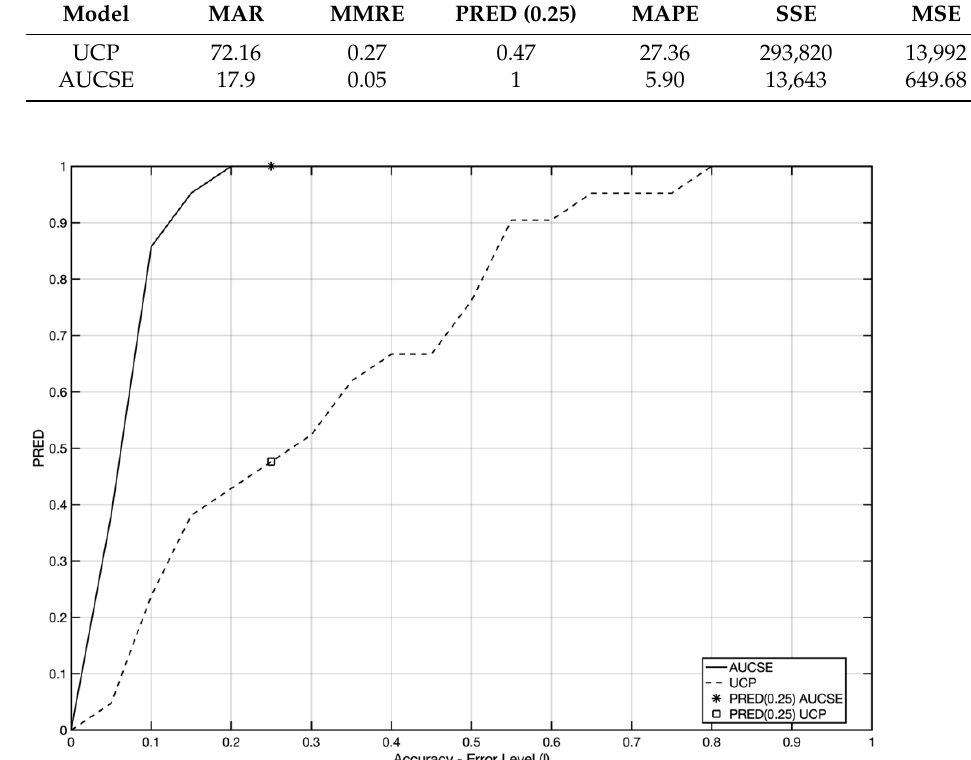
Figure 14. Comparison of the development of PRED for Actors and Use Cases Size Estimation (AUCSE) and UCP. PRED: number of projects with an error smaller than the entered value. Table 2. Comparison of UCP and AUCSE.